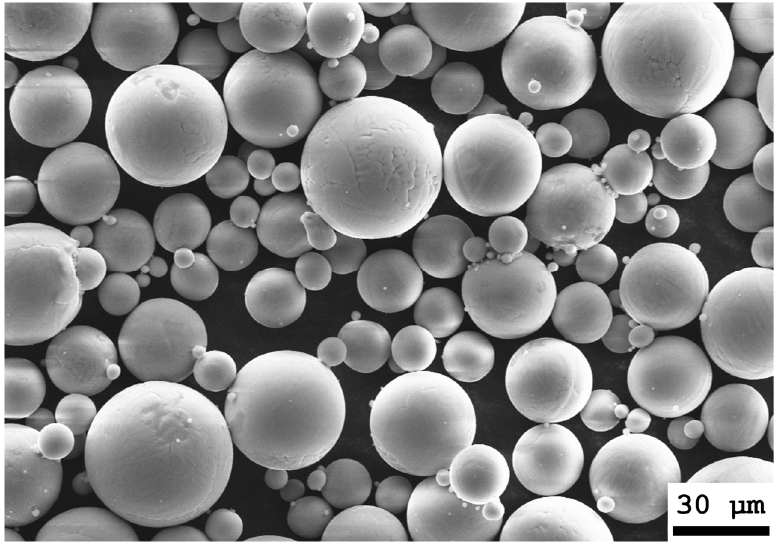
Figure 2. SEM image (Supra 25, Zeiss AG) of the processed Ti6Al4V Grade 5 powder. Four different scanning strategies are meant to create a pyramid-like anchoring struc- ture, made from Ti6Al4V, which penetrates the trabeculated bone tissue, and thus leads to increased anchorage of the implant.